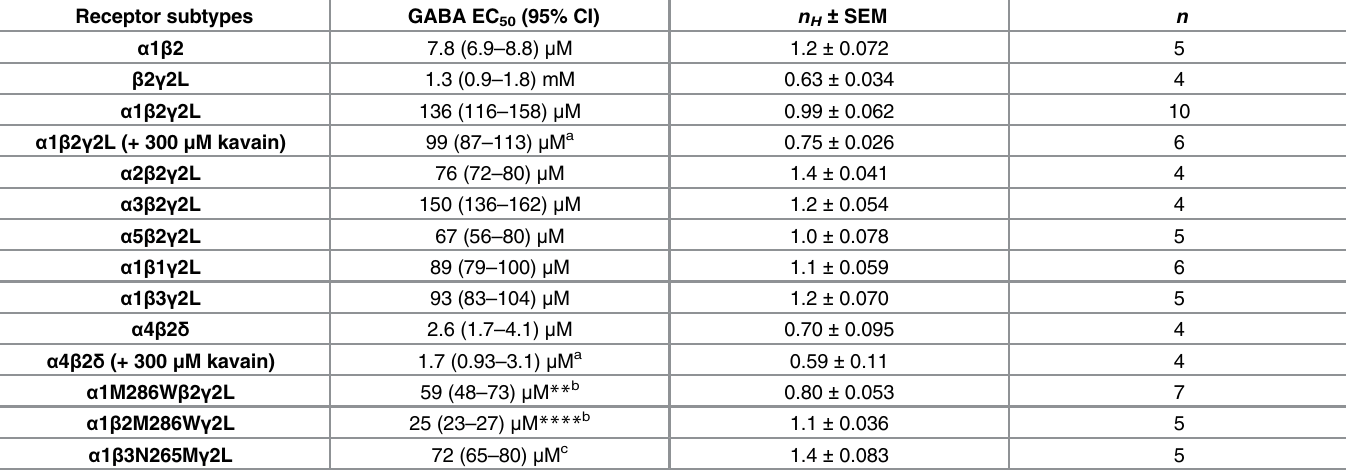
Table 1. GABA concentration-response curve parameters at various receptor subtypes derived from curve-fitting procedures. Receptor